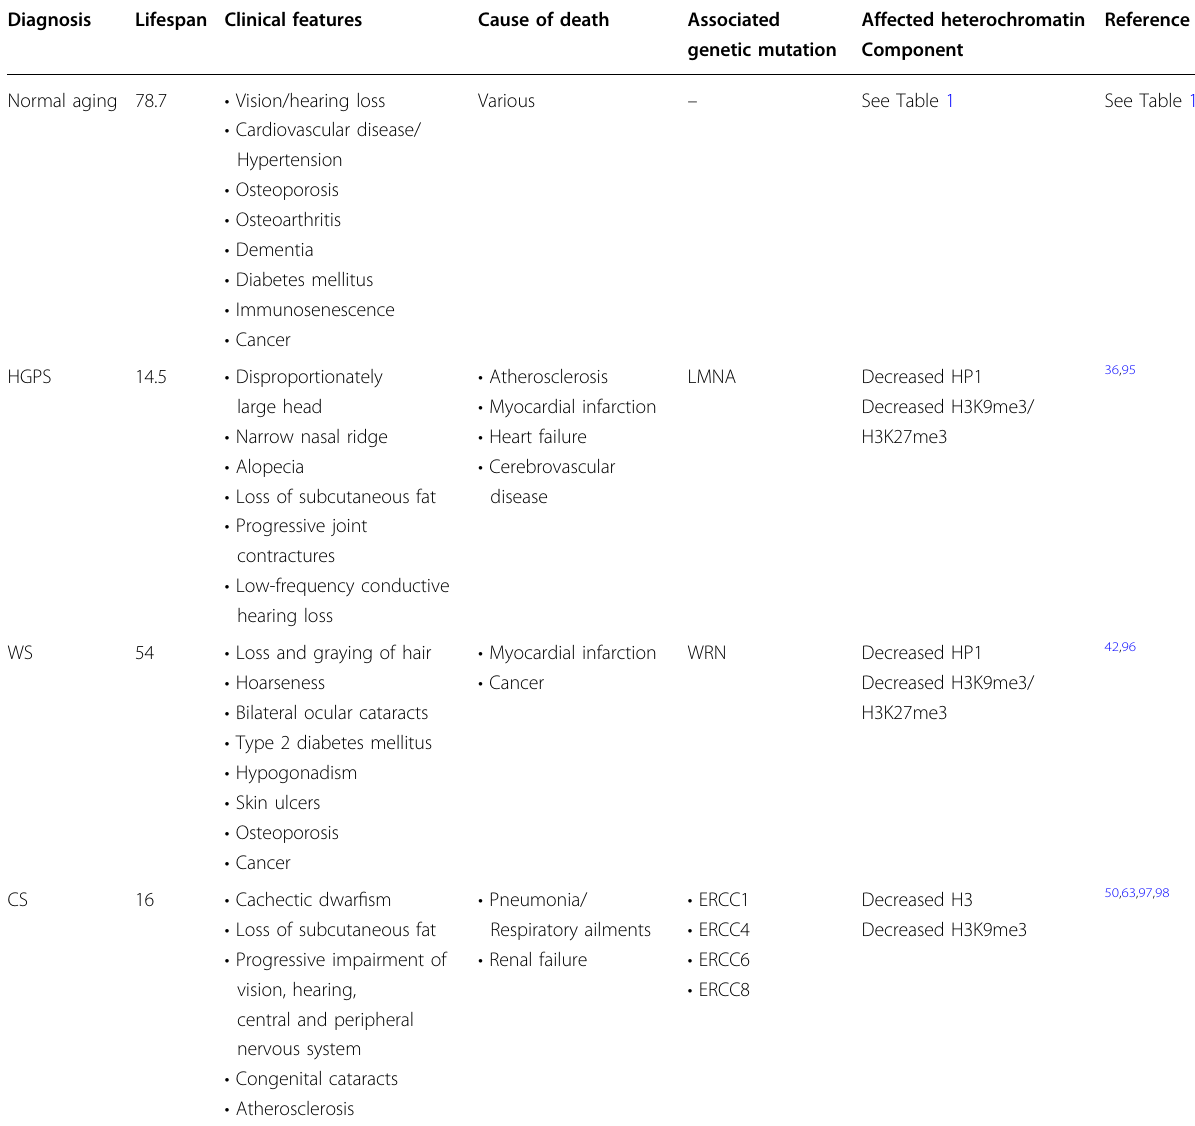
Table 2 Features of normal and premature